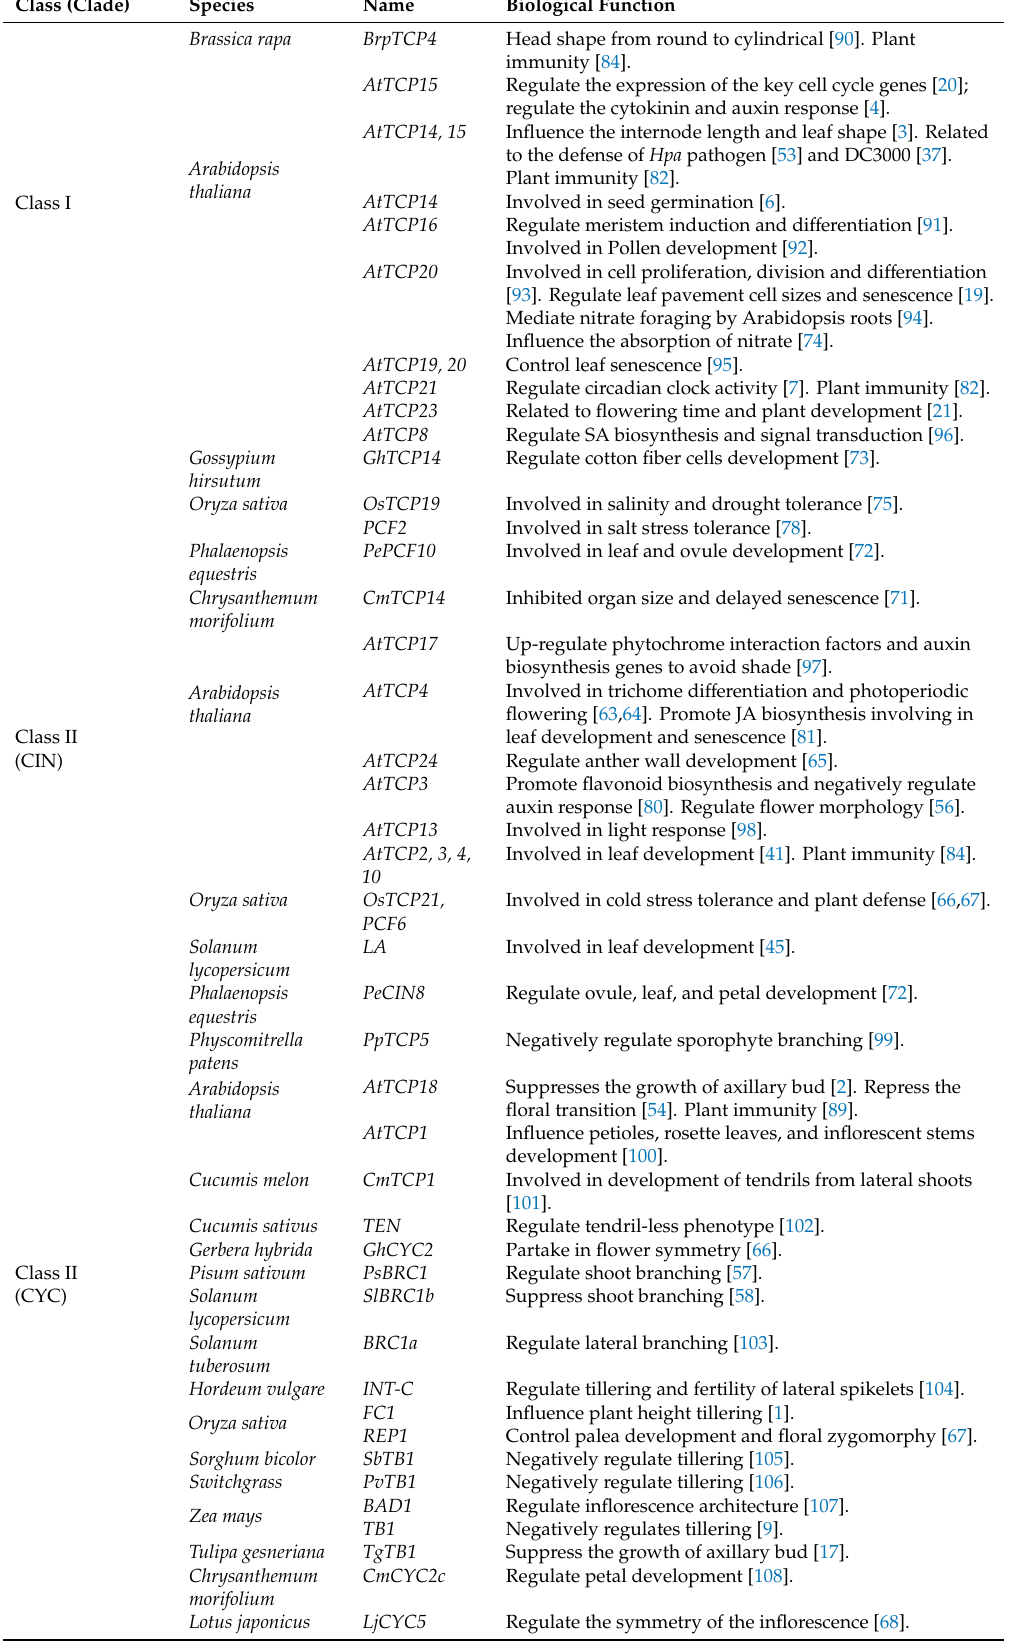
Table 1. Summary of the functionally characterized plant TCP genes found in the present study. Class